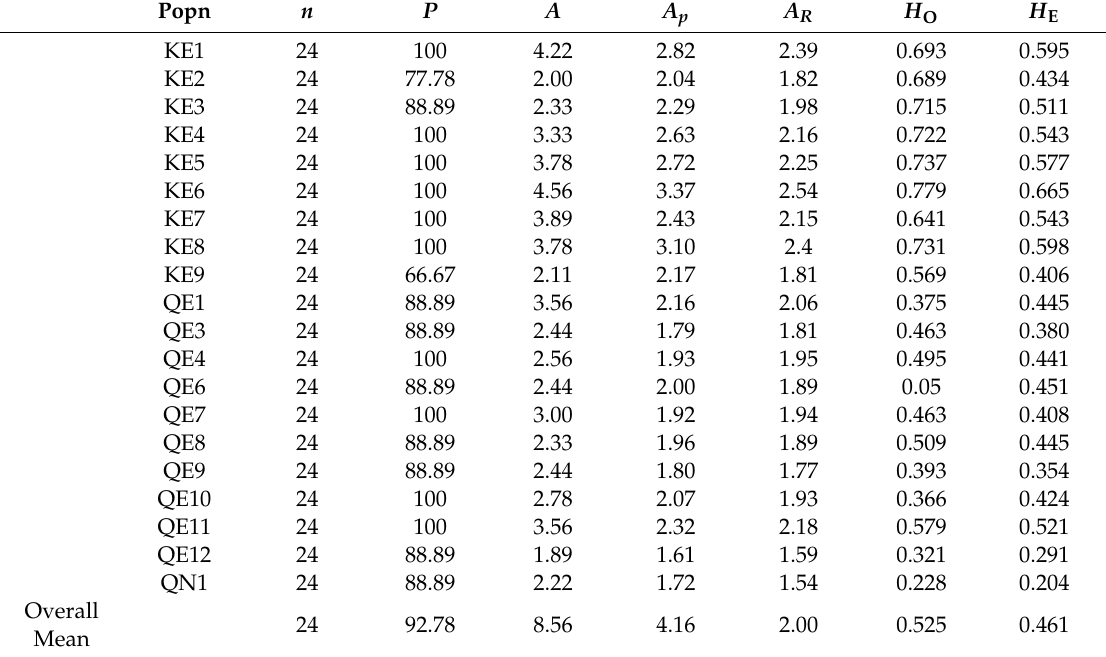
Table 5. Population genetic diversity parameters estimated in 19 invasive Phragmites australis populations of Quebec (Canada) and Kashmir (India) and one native population of the species in Quebec, based on nine microsatellite